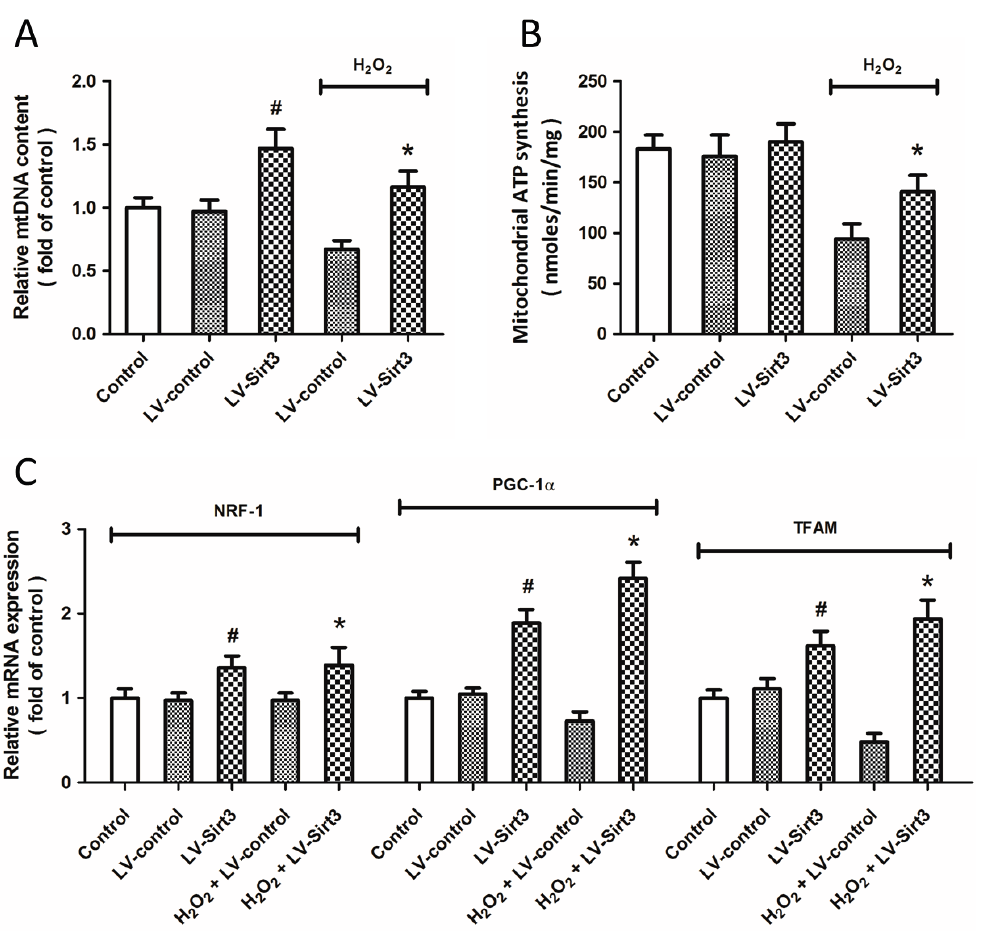
Figure 6. Overexpression of Sirt3 promotes mitochondrial biogenesis after H treatment. After transfection with lentivirus expressed Sirt3 (LV-Sirt3) or control lentivirus (LV-control) for 72 h, cortical neurons were treated with 0.1 mM H DNA (mtDNA) content ( A ) and mitochondrial ATP generation ( B ) were measured. The expression of NRF-1, PGC-1 α and TFAM at mRNA levels was measured by Real-Time RT-PCR ( C ). Data are shown as mean ± SD of five experiments. # p < 0.05 vs. Control. * p < 0.05 vs.